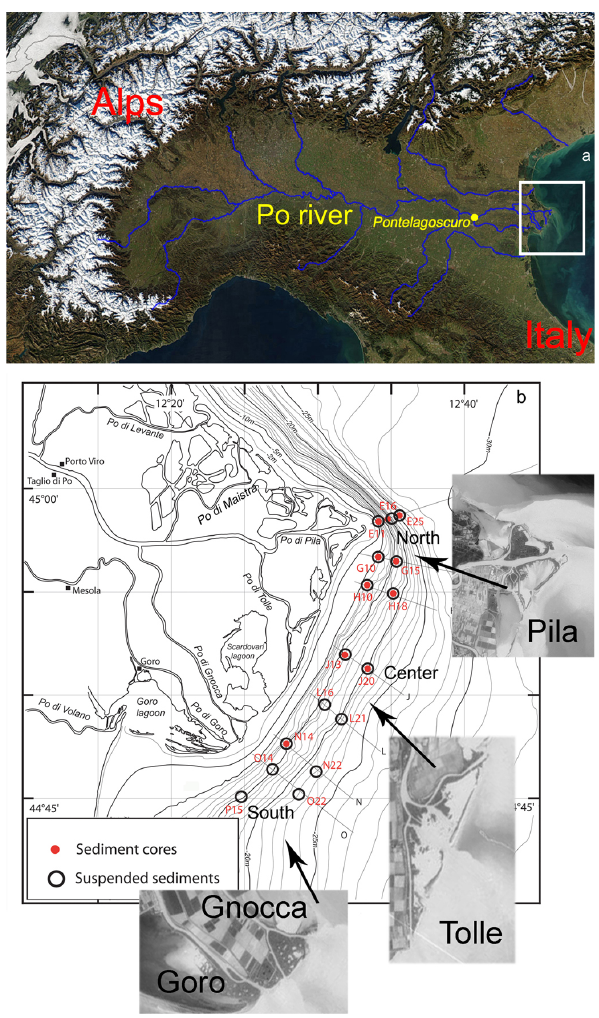
Fig. 1. (a) Satellite image of Northern Italy and the Po river drainage basin: open squares show the Po prodelta location (b) Map of the study area. Stations were grouped into subregions: north, center,